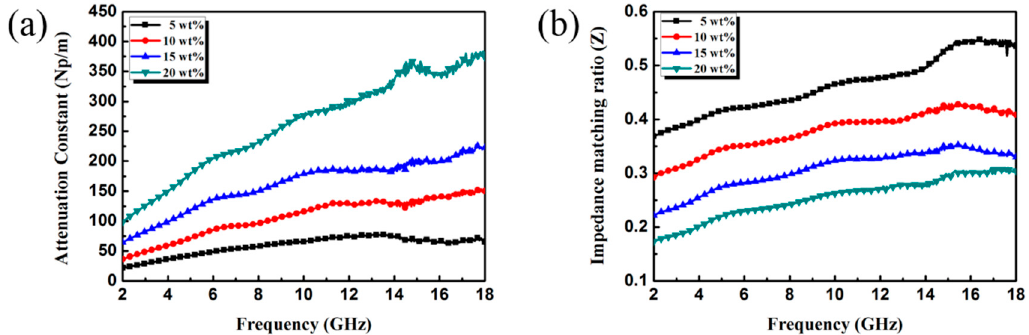
Figure 8. Attenuation constant ( a ) and impedance matching ratio ( b ) for paraffin composites containing different loading ratio of rGO/CuS/PPy.